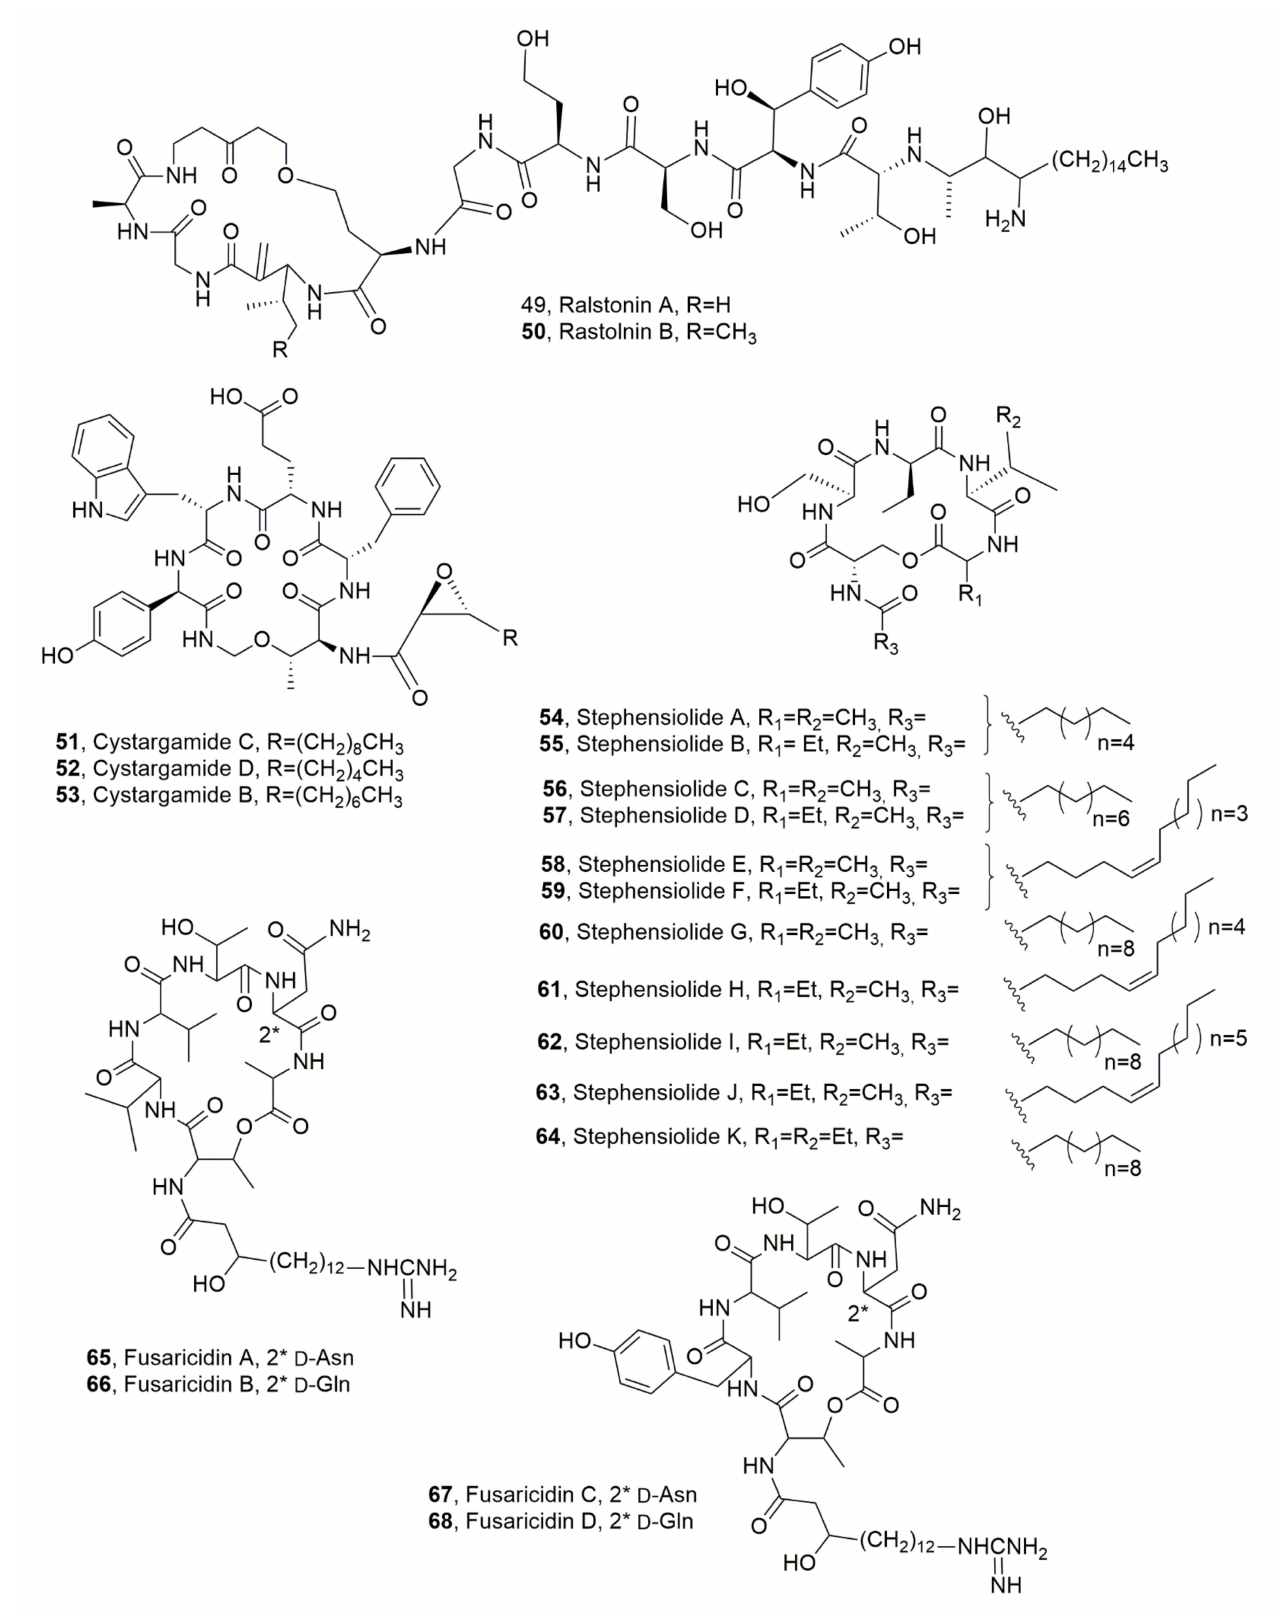
Figure 8. Structures of lipodepsipeptides produced by Ralstonia solanacearum ( 49 and 50 ), Streptomyces sp. ( 51 – 53 ), Serratia sp. ( 54 – 64 ) and Paenibacillus polymyxa ( 65 – 68